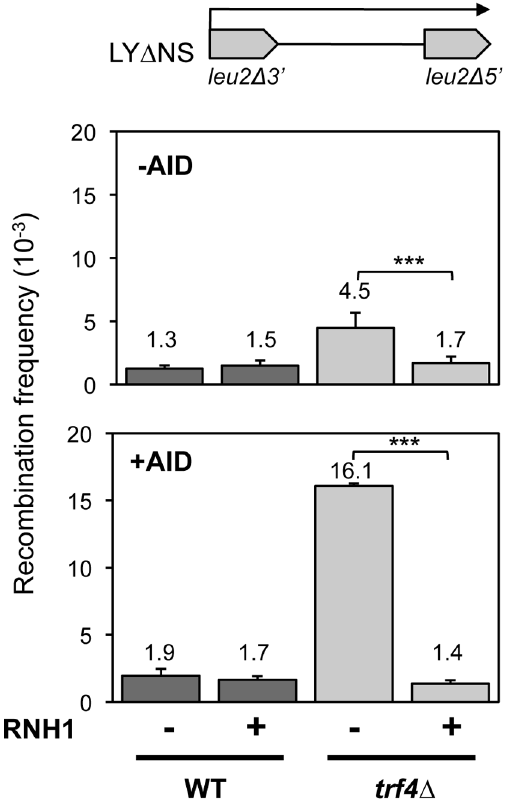
Figure 6. Genetic evidence for R-loop formation in trf4 D mutants. Effect of RNaseH1 and AID over-expression on the mutation frequency in trf4 mutants. Upper panel shows the analysis of recombination frequencies in W303-1A (WT) and TRF4D-C5 ( trf4 D ) cells containing the recombination system LY D NS, without RNaseH1 overexpression (-RNH1) or with over-expression of RNaseH1 ( + RNH1). The latter was achivied with the multicopy plasmid pGAL-RNH1 carrying RNH1 under the GAL1 promoter. Lower panel shows recombination frequencies as in the upper one, but over-expressing AID from plasmid p413GALAID. The average median value and SD of 3–4 fluctuation tests are shown. Other details as in Figure 2. Asterisks indicate statistically significant differences, according to Student’s t tests (***, R , 0.0005).